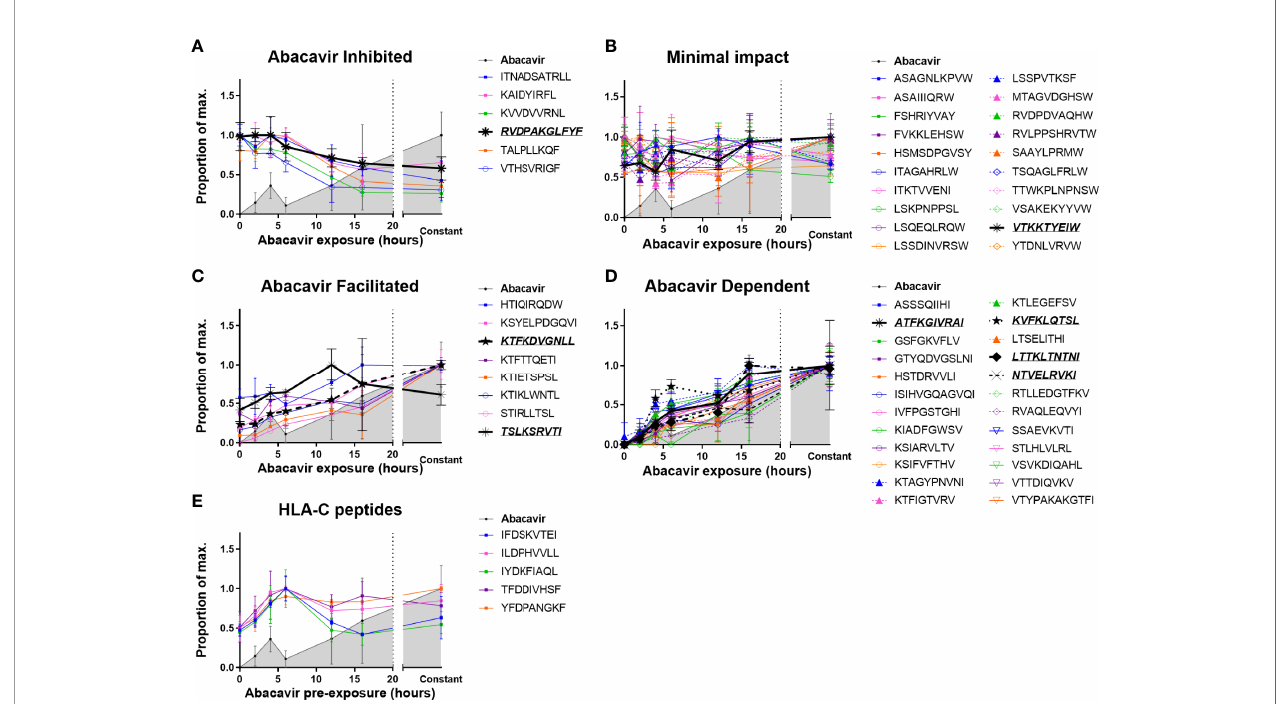
FIGURE 1 | Abacavir perturbs the HLA-B*57:01 immunopeptidome by increasing or decreasing the contribution of distinct subsets of peptides. Analysis of 58 selected HLA-B*57:01 peptide ligands, isolated from 10 8 C1R.B*57:01 cells after 0 – 16 h, or constant, abacavir treatment using LC-MRM – MS demonstrated four main patterns of impact on contribution to the immunopeptidome; (A) inhibition, (B) minimal impact, (C) facilitated (presented by HLA-B*57:01 of untreated cells but increased in abundance during abacavir treatment) and (D) dependent (only presented by HLA-B*57:01 of cells exposed to abacavir). Perturbation of HLA-B*57:01 ligands increased with time, coincident with increased co-puri fi cation of abacavir. Perturbations were not mirrored by the HLA-C ligands analysed (E) . Peptide and abacavir abundances are shown as a proportion of the maximum normalised peak area detected and are portrayed as the mean of the three biological replicates (mean +/ − SD). The decreased recovery of abacavir at the 6 h point is likely to re fl ect an experimental artefact in the off line fractionation prior to the LC-MS. Importantly there was not a similar decrease in the amount of peptide material eluted at this time point. Peptides that were chosen for in vitro peptide binding and dissociation experiments are in italics and